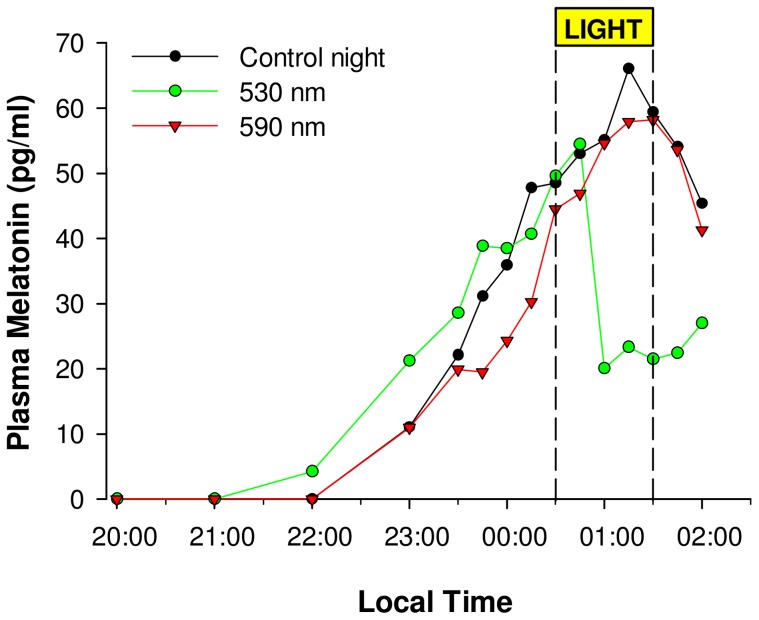
Evaluation of non-visual sensitivity to light via melatonin suppression.Profiles of plasma melatonin in a representative older subject during 3 experimental sessions, with exposures to 2 monochromatic lights (530 (green line) and 590 nm (red line)) of equal photon density, and a control dark session. Note the wavelength-dependent acute effects of the monochromatic lights compared to control (black line). A relatively stable phase angle of entrainment is observed for this subject across this 4 weeks' study segment.